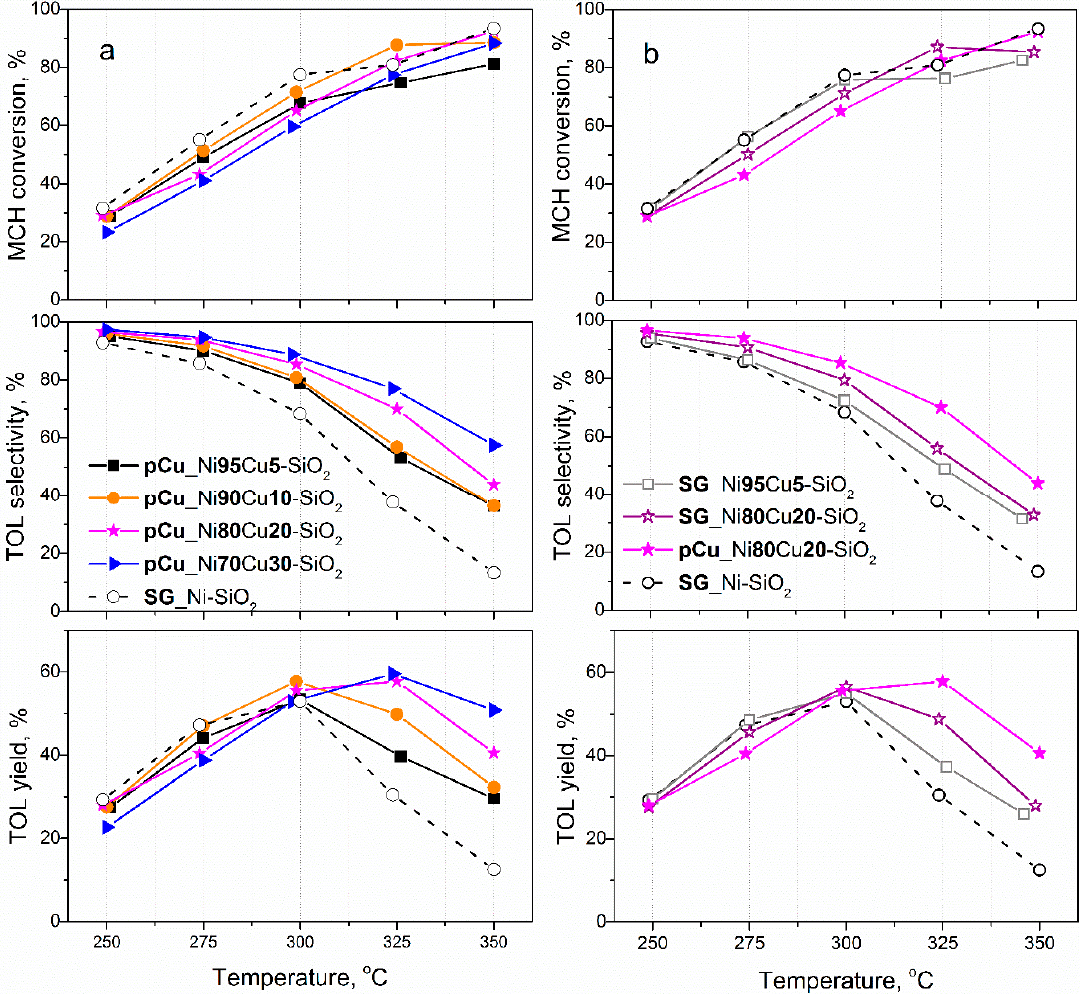
Figure 4. Comparative catalytic performance of pCu ( a ) and SG ( b ) catalyst series in methylcyclohexane (MCH) dehydrogenation. TOL means toluene. Reaction conditions: T = 250–350 °C, P = 0.1 MPa, m cat = 0.50 g, H 2 /Ar molar ratio equal to 1, gas feed rate of 400 mL/min, liquid feed rate of 12 mL/h.